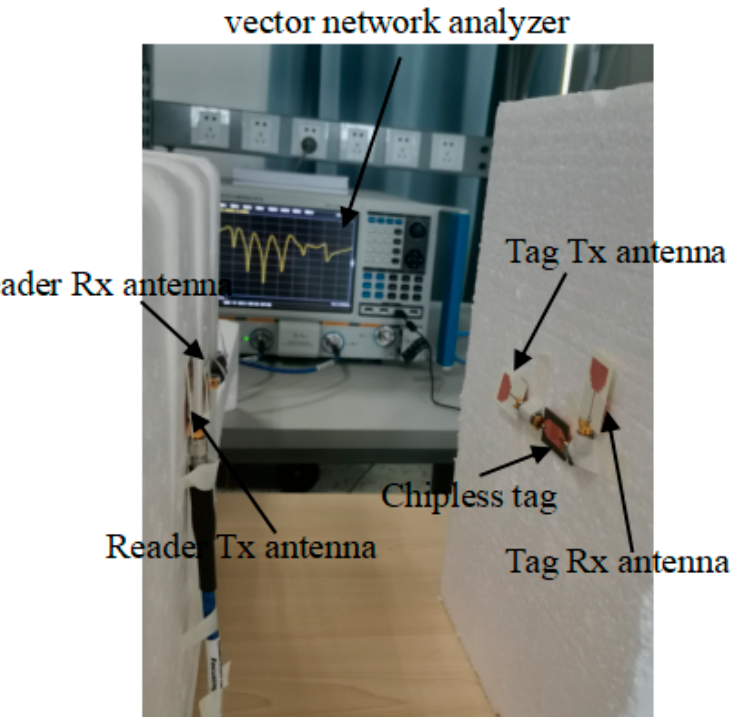
Figure 9. Test Figure 9. Test system.